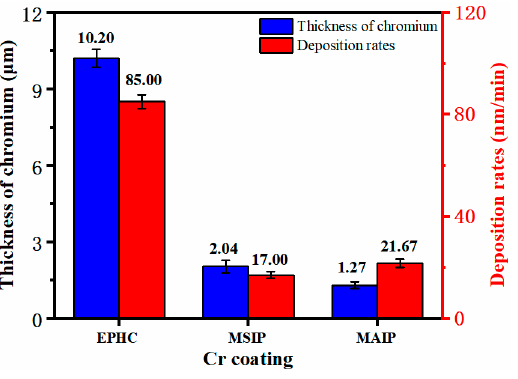
Figure 3. Thickness and deposition rates of chromium coatings deposited using EPHC, MSIP and MAIP.